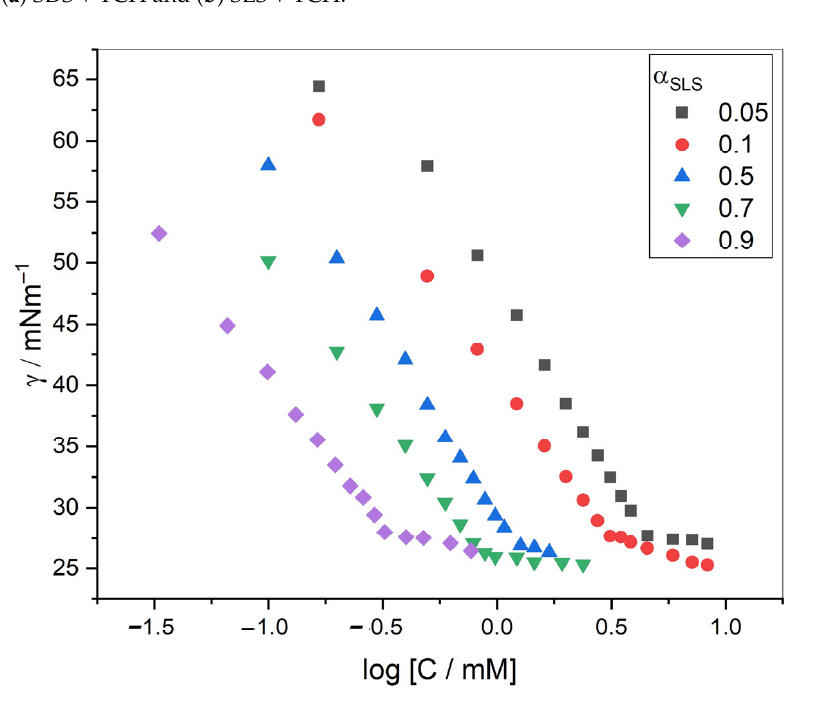
Figure 3. Graph of surface tension versus log molar concentration for SLS + TCH mixed